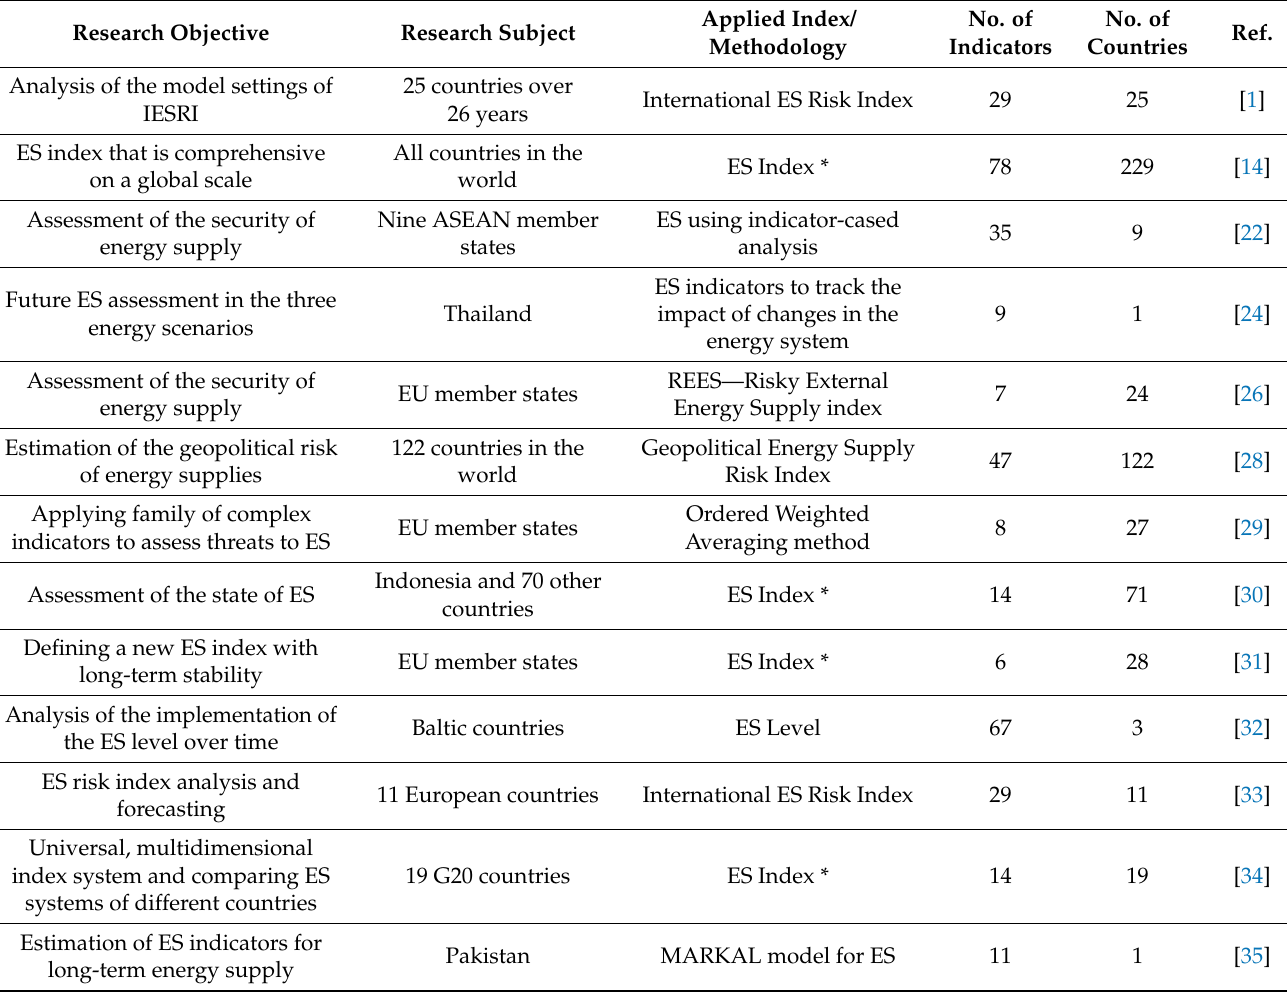
Table 1. Studies that measured countries’ energy security (ES) and risk using various methods and energy indices.